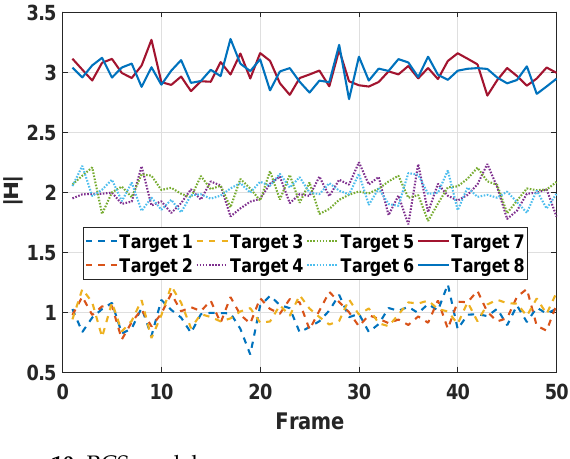
Figure 10. RCS model.